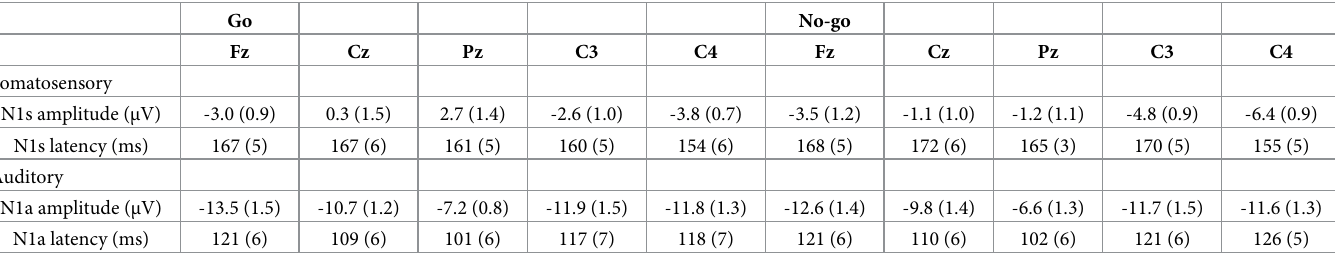
Table 2. Average values for peak amplitudes and latencies of N1s and N1a components with